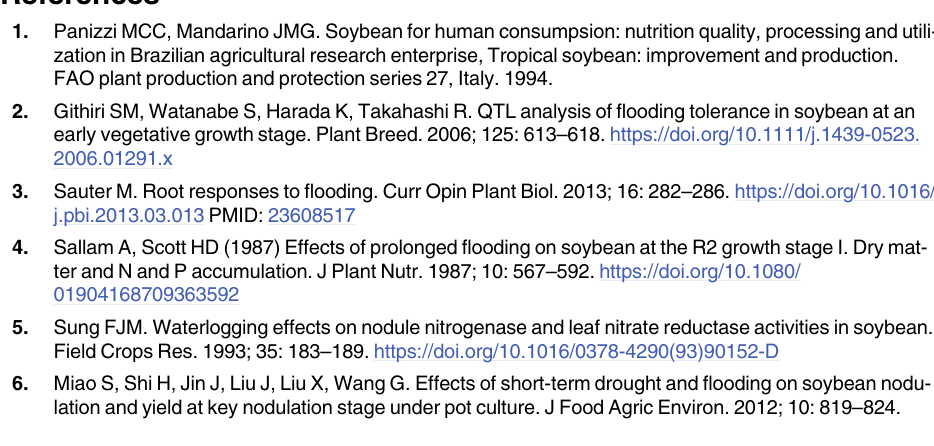
S1 Table. Sieve MS data of untreated control soybeans. S2 Table. Sieve MS data of flooded soybeans. S3 Table. Sieve MS data of 364 commonly identified proteins in control and flooded soy-